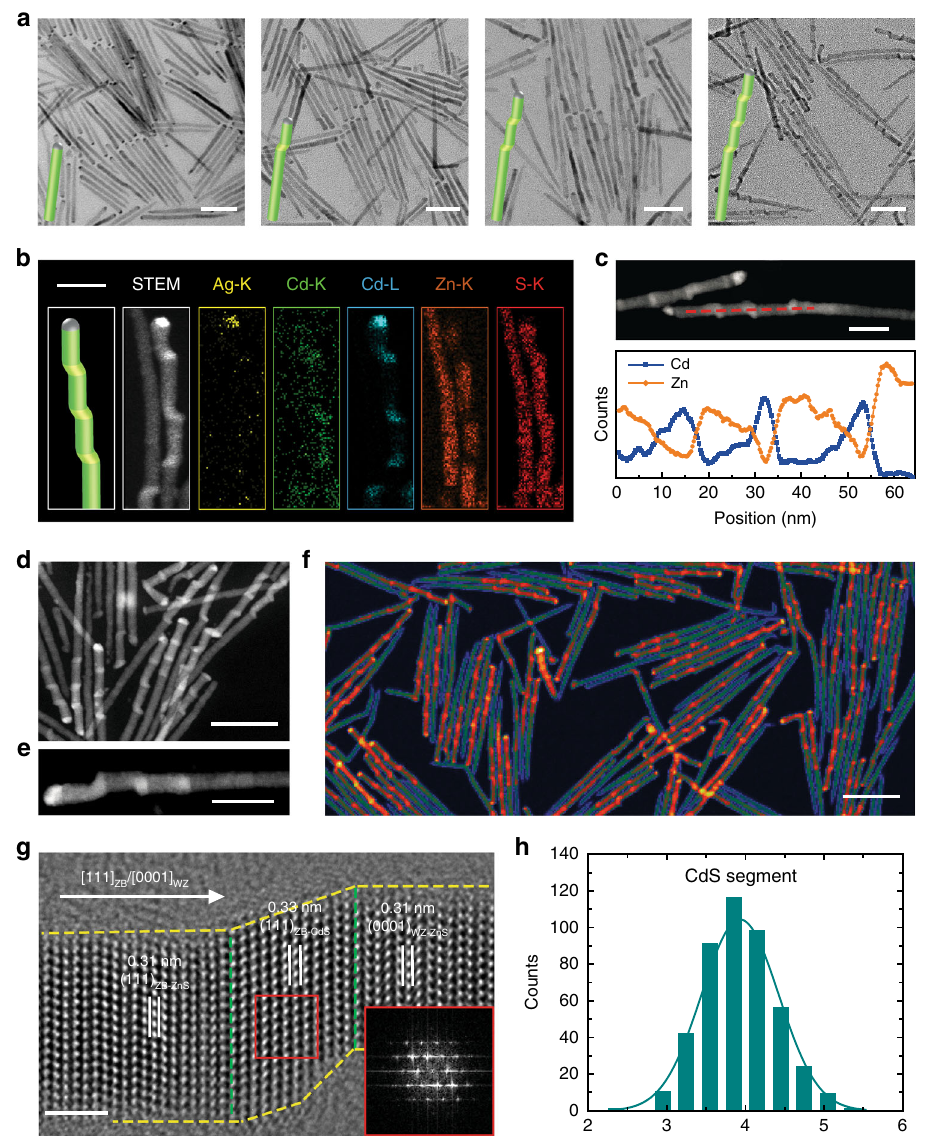
Fig. 2 Synthesis and characterization of CdS – ZnS QDNWs. a TEM images of QDNWs with zero to three CdS QDs (from left to right). b Dark- fi eld STEM images and EDS element mapping images of 3CdS-4ZnS QDNWs, shown with Ag-K (yellow), Cd-K (green), Cd-L (blue), Zn-K (orange), and S-K (red) signals. c EDS line-scan pro fi les of the 3CdS-4ZnS QDNW along the red dash line in dark- fi eld STEM image. d Representative dark- fi eld STEM image of 3CdS-4ZnS QDNWs. e Enlarged dark- fi eld STEM image of single 3CdS-4ZnS QDNW. f Low-magni fi cation pseudocolored dark- fi eld STEM image of 3CdS- 4ZnS QDNWs. CdS QDs with high contrast are uniformly distributed in nanowires. g Representative HRTEM image of one CdS QD sandwiched between two ZnS segments, featuring a [111] ZB /[0001] WZ epitaxial direction. Inset: the FFT image of CdS segment (red square). h Axial length distribution of CdS QDs in 3CdS-4ZnS QDNWs. Scale bars are 50 nm for a , d , and f , 20 nm for b , c , and e , and 2 nm for g ,